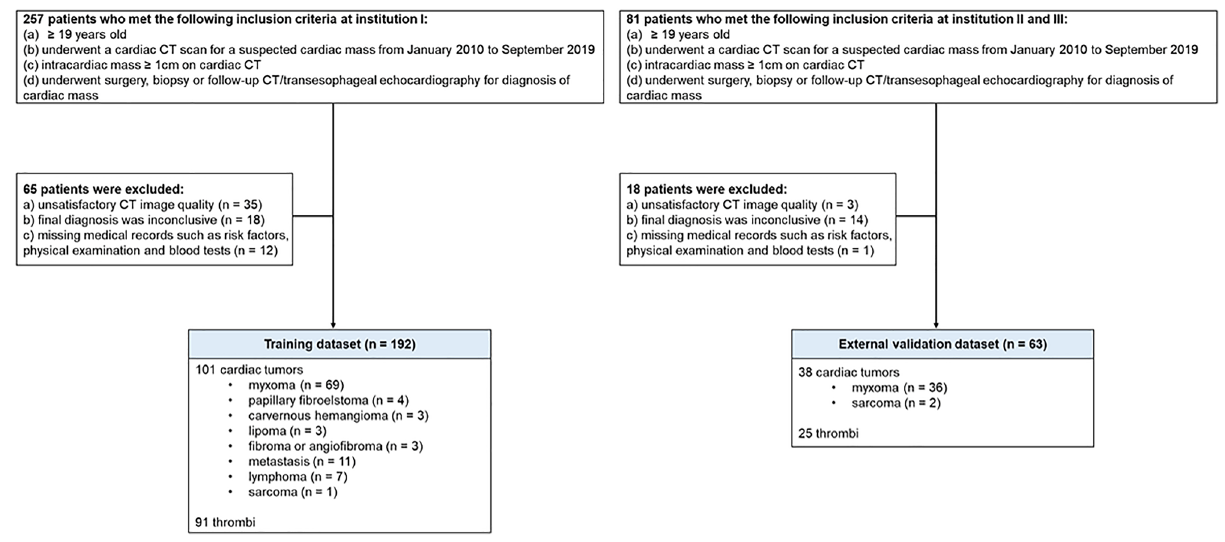
Figure 1. Patient selection